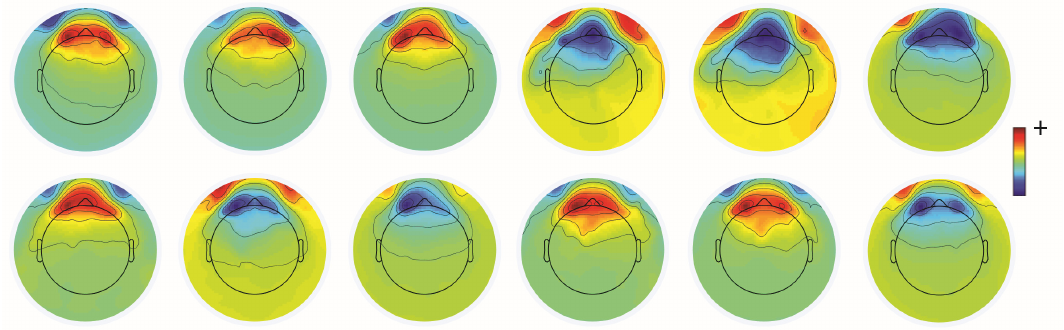
Figure 2. Topography of eye blinks. Maps from 12 individual subjects display the typical anterior topography of eye blinks as identified by independent component analysis (ICA) in EEG data (see also the text in the “Preprocessing and Analysis” section for more detail on the method). Nose is at top, inion at the bottom, and left and right hemispheres appear on the left and right. The color scale depicts arbitrary units.